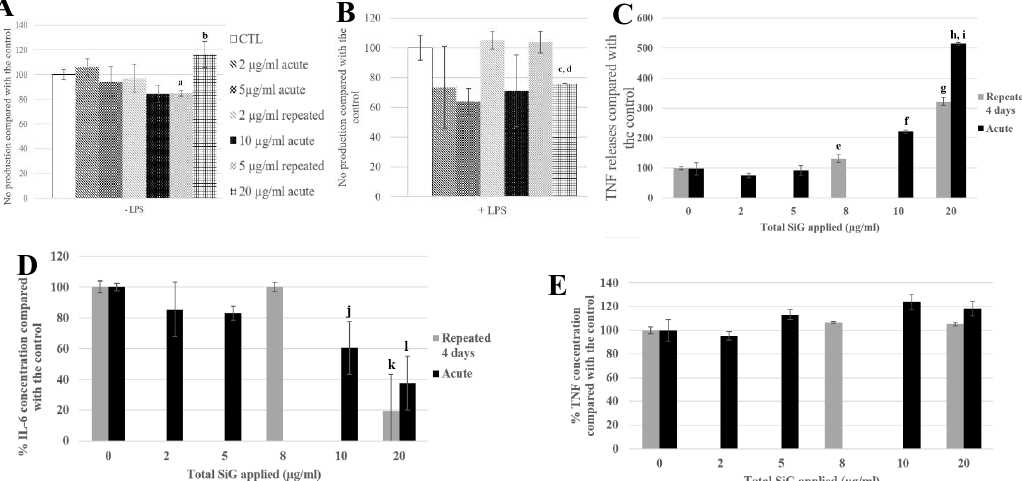
Figure 6. 4-day chronic exposure of RAW264.7 to SiG NP and 18 h to LPS compared with silica acute exposure. ( A , B ) NO dosage with the Griess reagent by spectrophotometry without or with LPS stimulation (a: CTL versus repeated 5 µg/mL, p -value < 0.05; b: repeated 5 µg/mL versus acute 20 µg/ml, p value < 0.01, c: CTL versus acute 20 µg/mL, p -value < 0.01; d: repeated 5 µg/mL versus acute 20 µg/mL, p -value < 0.05). ( C ) TNF releases of RAW264.7 cells exposed to SiG only, measured by flow cytometry (e: CTL versus repeated 2 µg/mL, p -value < 0.05; f: CTL versus acute 10 µg/mL, p -value < 0.001; g: CTL versus repeated 5 µg/mL, p -value < 0.001; h: CTL versus acute 20 µg/mL, p -value < 0.001; i: repeated 5 µg/mL versus acute 20 µg/mL, p -value < 0.01). ( D , E ) Cytokine release measurement of LPS stimulated cells by flow cytometry, respectively IL-6 and TNF. (j: CTL versus acute 10 µg/mL, p - value < 0.05; k: CTL versus repeated 5 µg/mL, p -value < 0.001; l: CTL versus acute 20 µg/mL, p -value < 0.01).